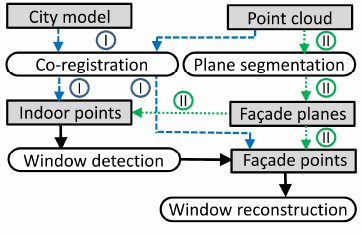
Figure 3. Processing steps (dashed: using model and point cloud (I); dotted: using only point cloud